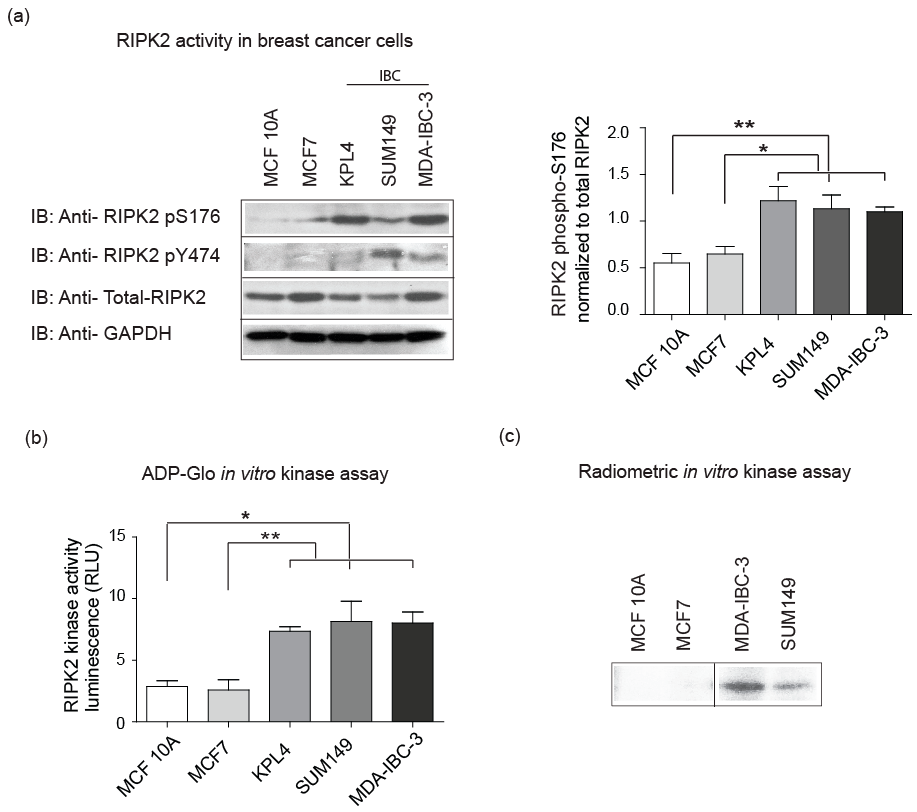
Figure 2. RIPK2 is hyperactive in IBC cell lines: ( a ) equal concentrations of samples were loaded and immunoblotted (IB) with an antibody to the active form of RIPK2 using a RIPK2 phospho (p) –Serine (S) 176, RIPK2 phospho (p) -tyrosine (Y) 474 or an antibody that recognizes total RIPK2. GAPDH (Glyceraldehyde 3-phosphate dehydrogenase) expression is used as a loading control for whole cell lysate. Signal was developed using enhanced chemiluminescence (ECL). * p -value for the difference between MCF 10A and KPL4, SUM149, and MDA-IBC-3 is 0.01, 0.02, and 0.004, respectively. ** p -value for the difference between MCF7 and KPL4, SUM149, and MDA-IBC-3 are 0.02, 0.03, and 0.001; ( b ) luminescent ADP-Glo in vitro RIPK2 kinase assay in breast cancer cell lines. RIPK2 was immunoprecipitated and kinase activity was then measured by quantifying luminescence (RLU) that correlates to the percentage of ADP produced during the enzymatic reaction as per manufacture instructions. * p -value for the difference between MCF 10A and KPL4, SUM149, and MDA-IBC-3 are 0.004, 0.09, and 0.04, respectively. ** p -value for the difference between MCF7 and KPL4, SUM149, and MDA-IBC-3 is 0.01, 0.03, and 0.02, respectively; and ( c ) radioactive in vitro kinase assay in different breast cancer cell lines (cut from the same gel). RIPK2 was immunoprecipitated and kinase activity was then determined using radioactively labeled ATP. The autophosphorylation site of Y474 of RIPK2 is visualized using standard autoradiography. All the data shown are representative of the results of two to four independent experiments. KPL4 revealed similar constitutively active level of RIPK2 [43].